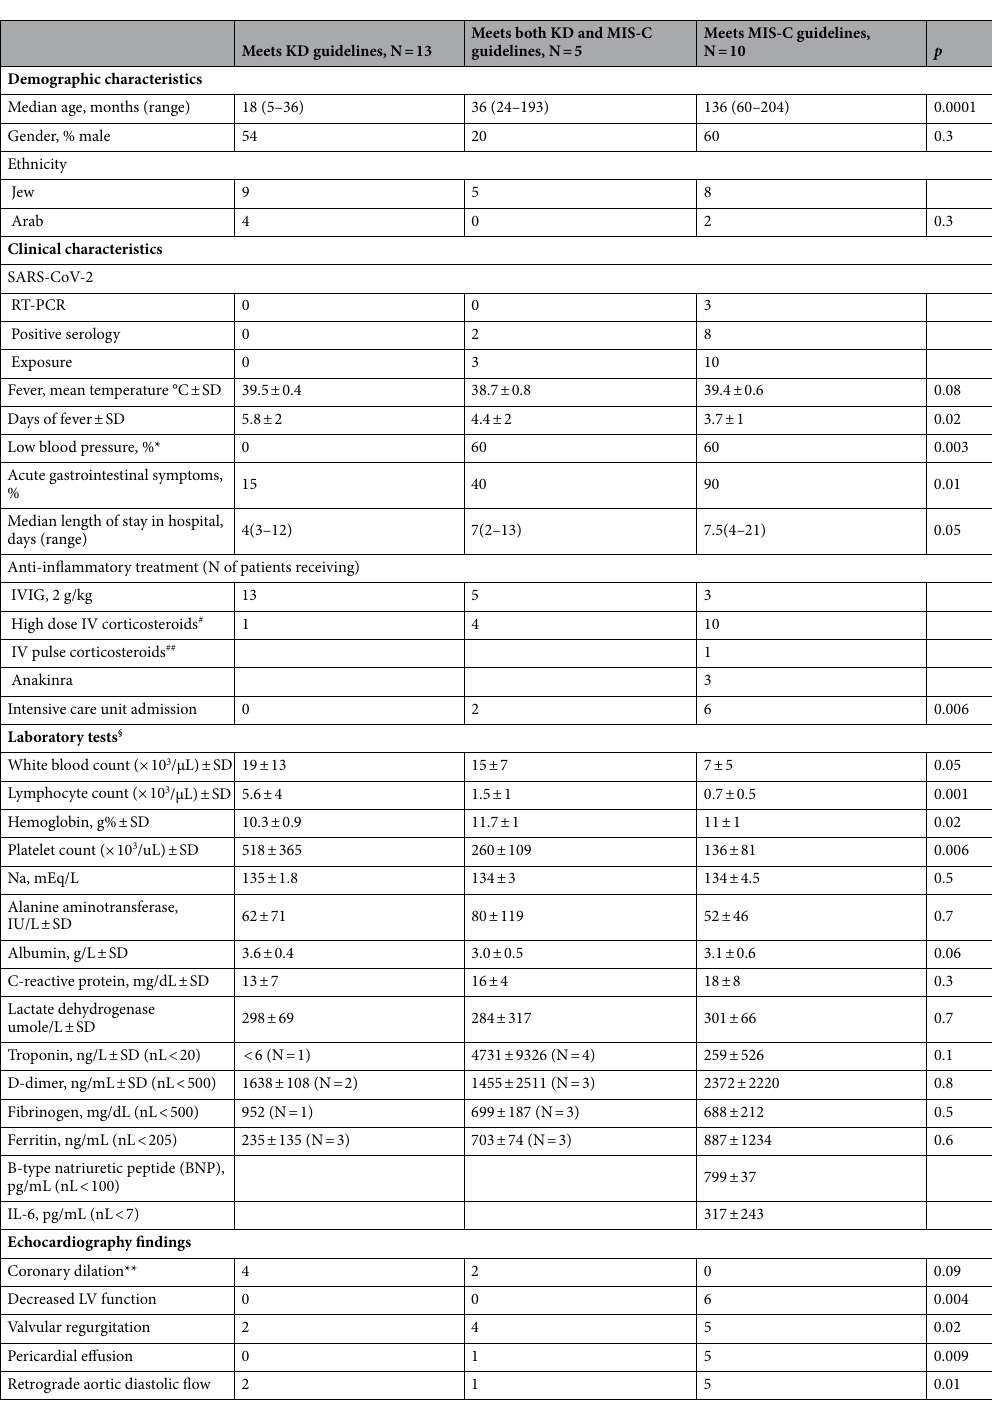
Table 1. Clinical and laboratory characteristics of patients with Kawasaki disease (KD), Multisystem Inflammatory Syndrome in children (MIS-C) and of patients meeting criteria for both conditions. IVIG intravenous immunoglobulins, LV -left ventricular. § Laboratory values are from the day of admission. Median days of illness for the laboratory values were: 5 (± 1.9) for KD patients, 3(± 1.6) for MIS-C patients and 4(± 3) for patients who met both sets of criteria, (the first day of fever considered as day #1 of illness). *Low blood pressure according to norms for age. # IV Methylprednisolone 2 mg/kg. ## IV Methylprednisolone 30 mg/kg. **3 KD patients with median left anterior descending artery (LAD) Z score of 2.8 (2.2–2.8), 1 KD patient with right coronary artery (RCA) Z-score of 2.8; 2 patients with both KD and MIS-C with LAD Z-score of 2.4 and 2.6 and RCA Z-score of 2.2 and